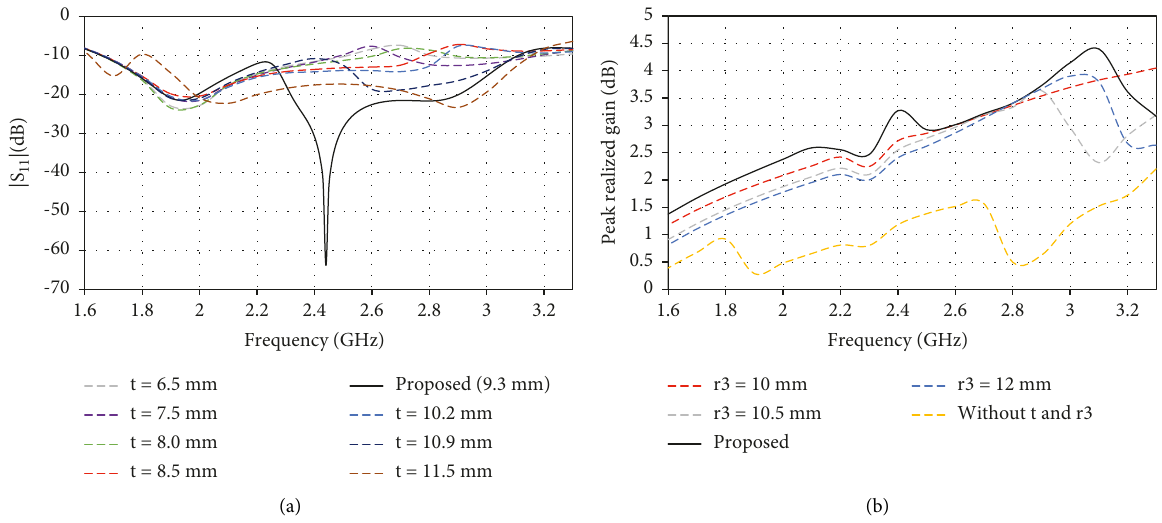
Figure 5: (a) Parametric analysis of the centered rectangular slot t and (b) influence of t and r 3 on gain.